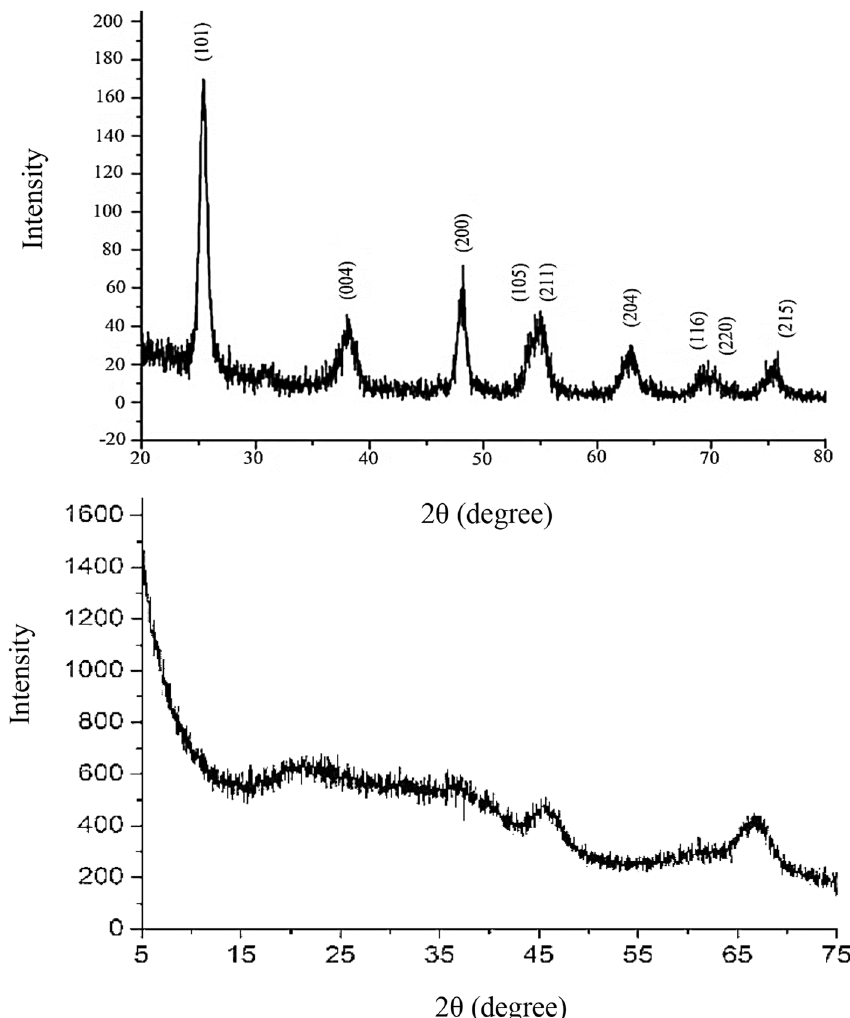
Figure 3. The XRD pattern of (A) TiO 2 and (B) γ-Al 2 O 3 nanoparticles.